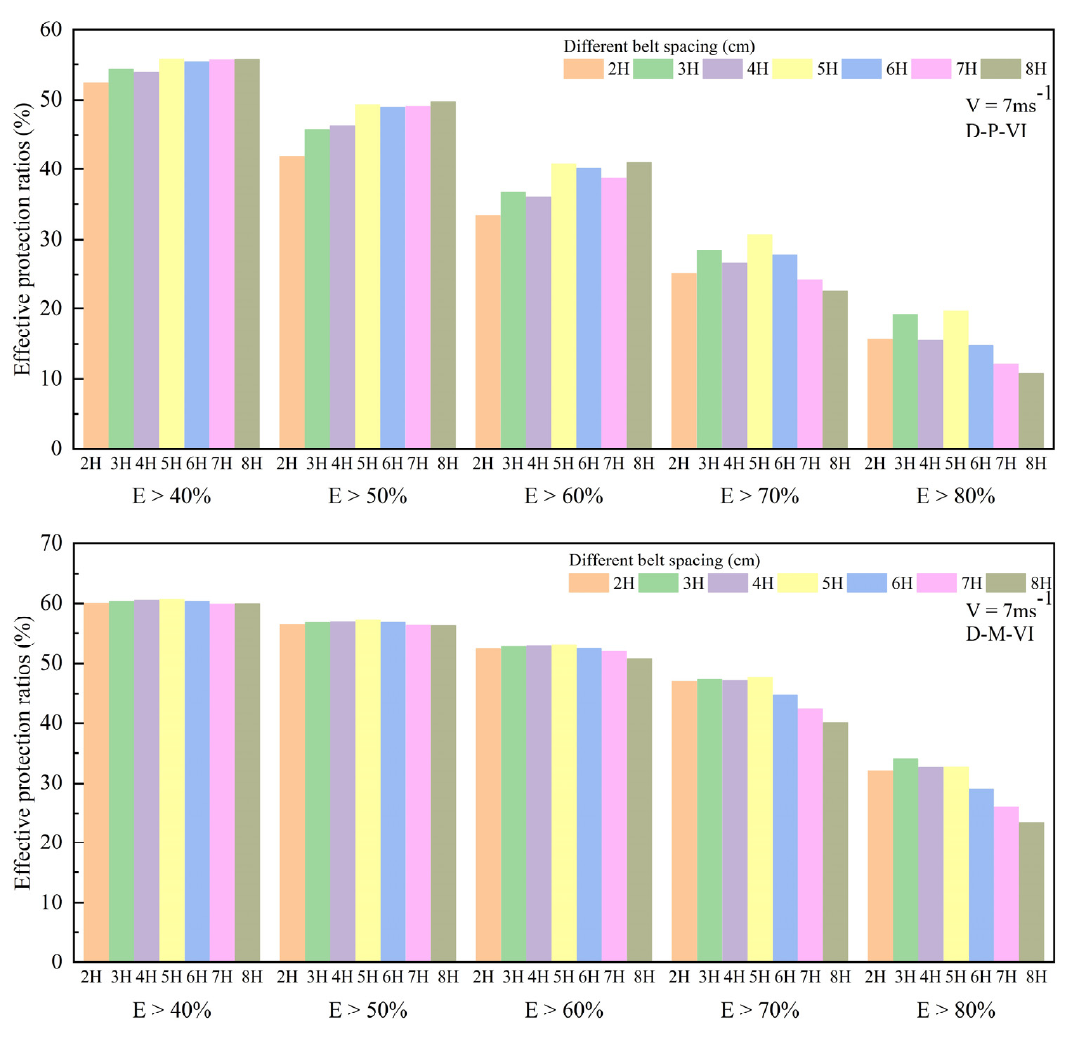
Figure 11. Effective protection ratio between double shelterbelts with different belt spacings at a vertical height of 0H–3H. The abscissa represents the shelterbelt with different belt spacings under a certain shelter efficiency. For example, “6H–50%” indicates a protection forest with a shelter effi- ciency of ≥ 50% and belt spacing of 6H. The belt spacing ranges from 2H to 8H.